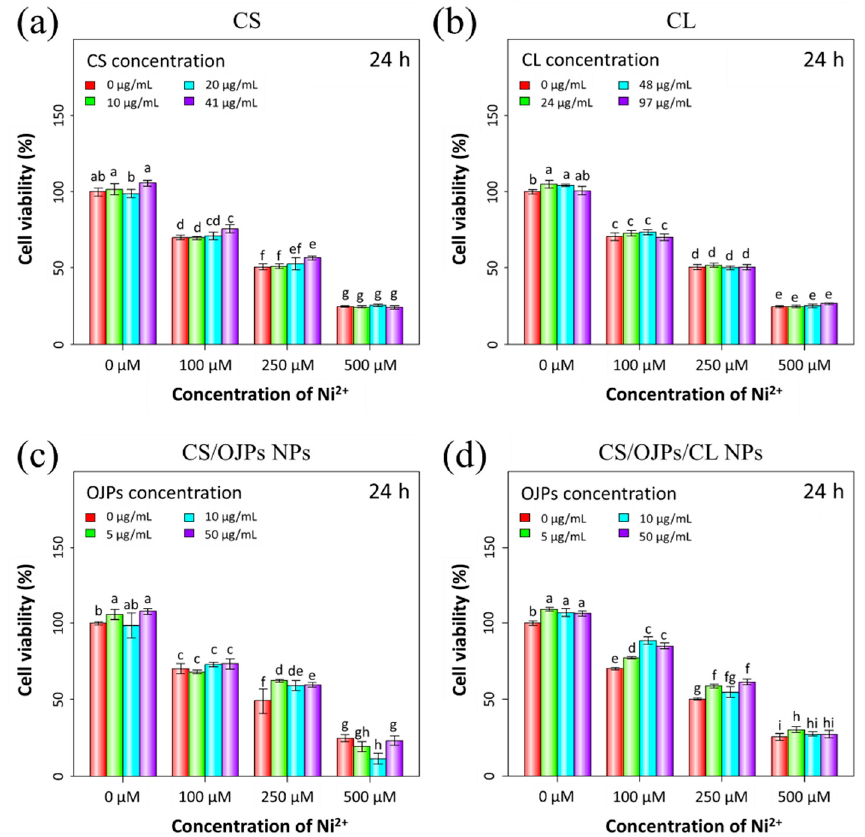
Figure 8. Inhibitory effect of CS/OJPs and CS/OJPs/CL NPs against Ni 2+ -induced cytotoxicity in RAW264.7 cells. Raw materials ( a , b ) and nanoparticles ( c , d ). The different lowercase letters represent statistically significant differences ( p < 0.05).